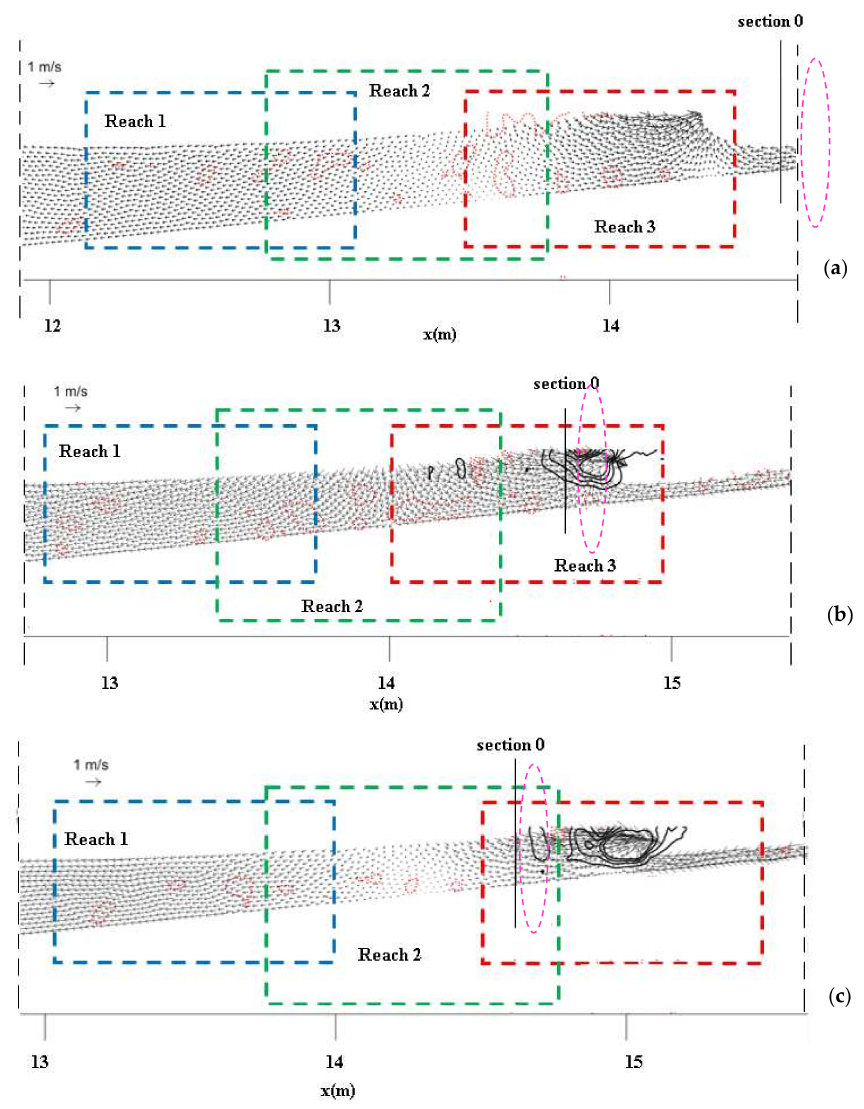
Figure 8. Sketch of the flow region with indication of the flow reaches where the vorticity field has been investigated in detail: ( a ) before; ( b ) during and ( c ) after breaking. The increment for each negative (red dashed lines) and positive (black solid lines) contour line is 1 s − 1 . The dashed oval shows the region where the sections for the experimental analysis of vorticity were